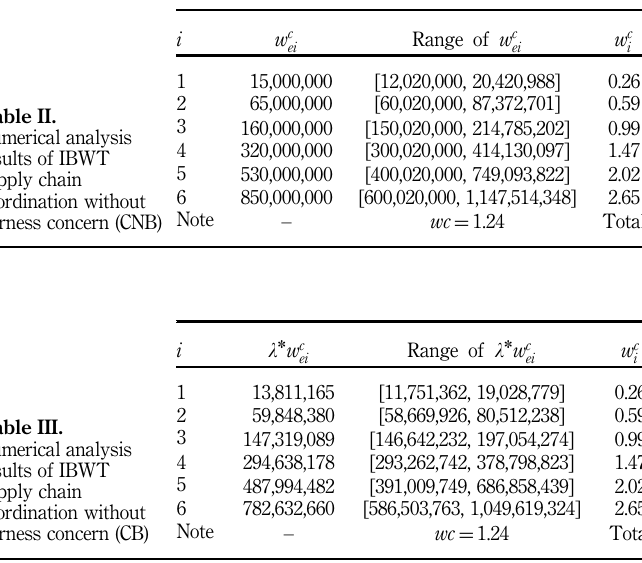
Table I. Parameters in the IBWT supply chain for the numerical analysis